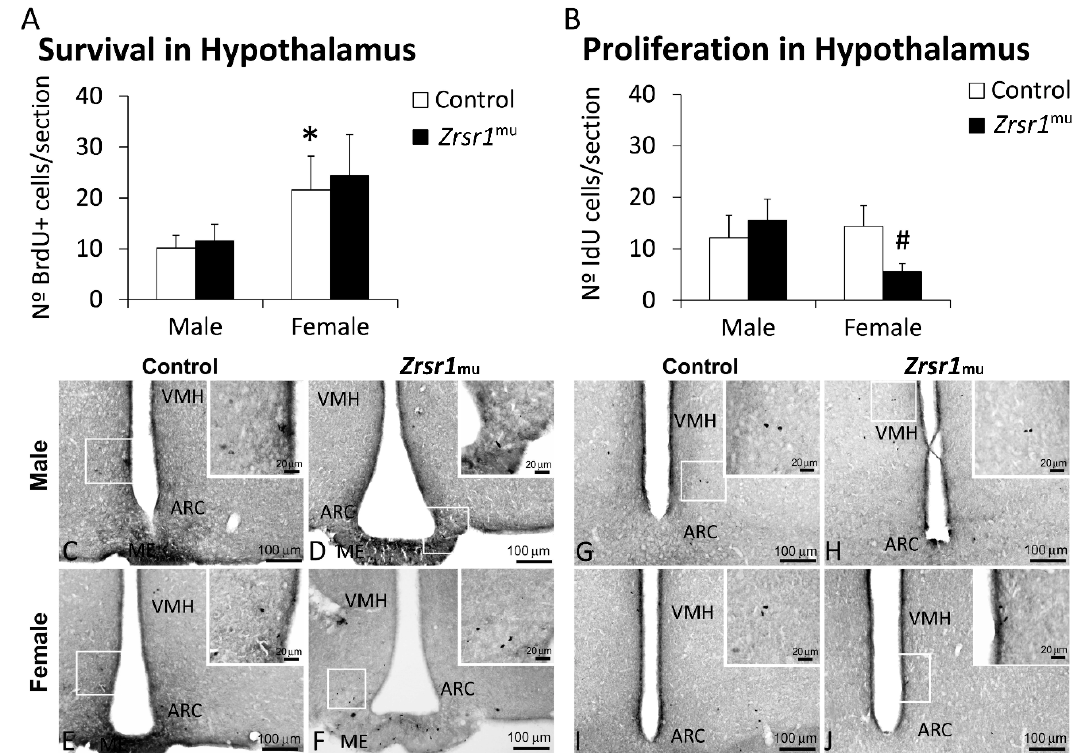
Figure 6. Newborn cell survival ( A ) and neural stem cell proliferation ( B ) respectively assessed by the number of BrdU- and IdU-immunoreactive (+) cells in the hypothalami of male and female wild-type and Zrsr1mu mice. Low- and high-resolution photomicrographs of representative images showing BrdU+ cells (C–F) and IdU+ cells (G–J). Arrowheads indicate labeled nuclei. Bars represent the mean ± SEM ( n = 7–8/group). Tukey ( A ) or simple effect analysis ( B ): ∗ p < 0.05 female vs. control male and # p < 0.05 wild-type vs. Zrsr1 mu . ARC, arcuate nucleus; VMH, ventromedial hypothalamus; ME, median eminence.